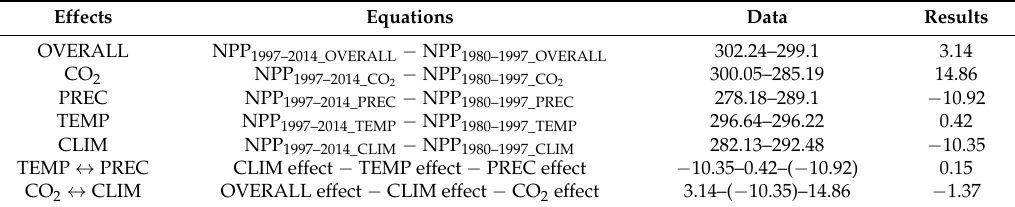
Table 4. Results of factorial